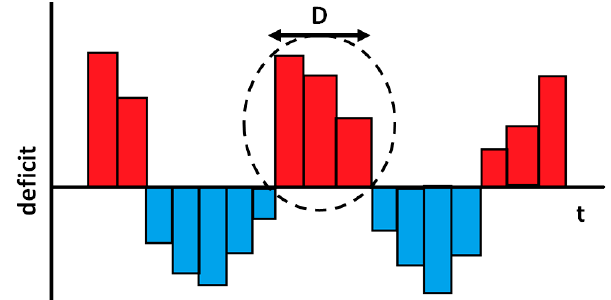
Figure 1. Schematic of drought properties.